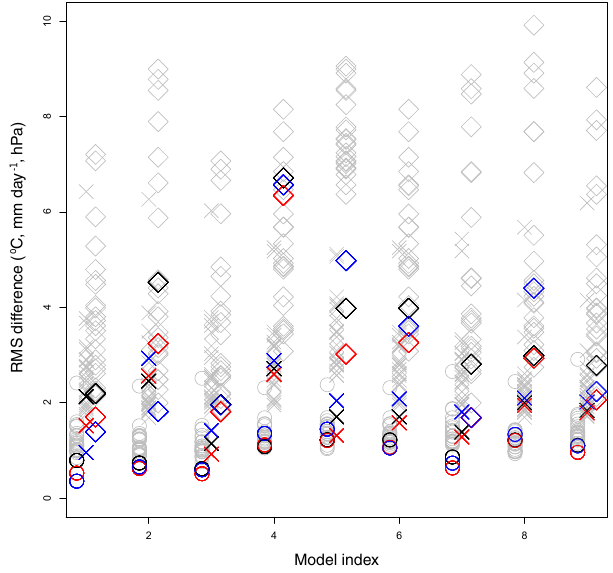
Figure 1. Analysis of CMIP3 models. The x axis indexes the nine model pairs being considered. Crosses represent TAS, circles PREC and diamonds PSL. Grey symbols indicate RMS distances of all models from the target model of the pair. Black symbols indicate distance of target model from mean of residual ensemble, blue sym- bols indicate distance of target model from plausibly related model, and red indicates distance of target model from interpolated pre- diction described in the text. The blue symbols being closer to zero than almost all grey symbols shows that related models are typically closer together than randomly selected models, and comparing red and black symbols shows that the interpolation improves as a pre- dictor over the ensemble mean in almost all individual cases, and